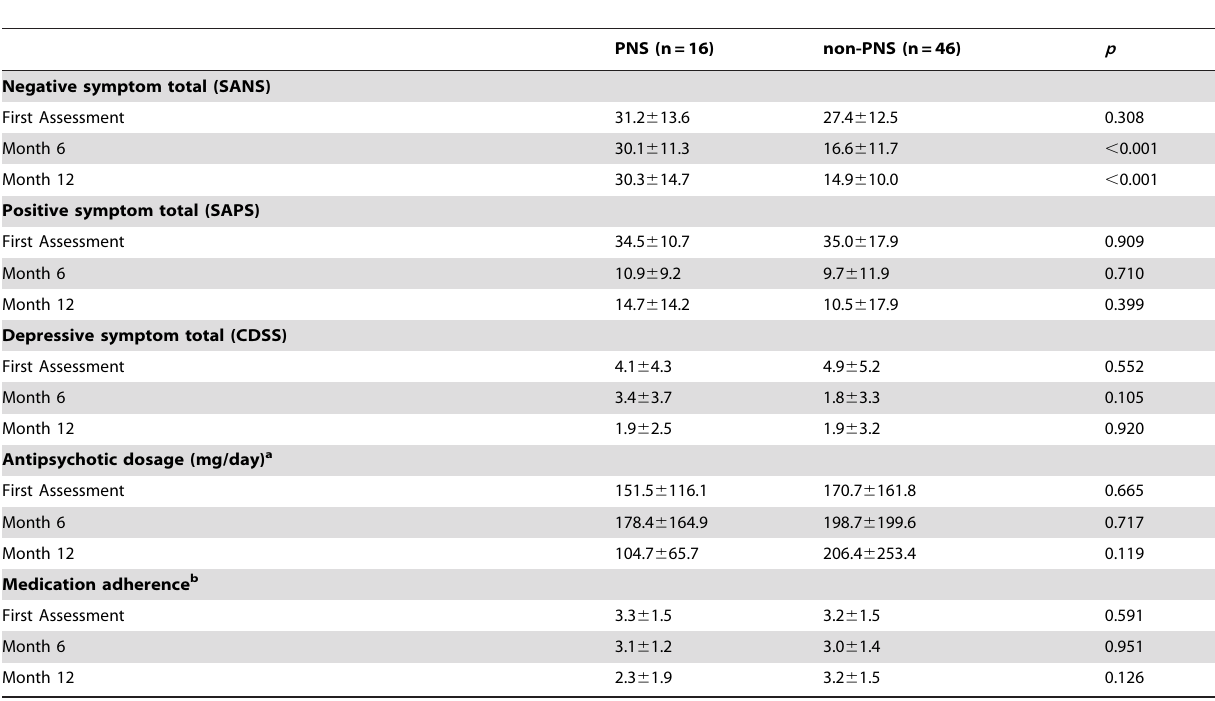
Table 2. Clinical characteristics for PNS patients and non-PNS